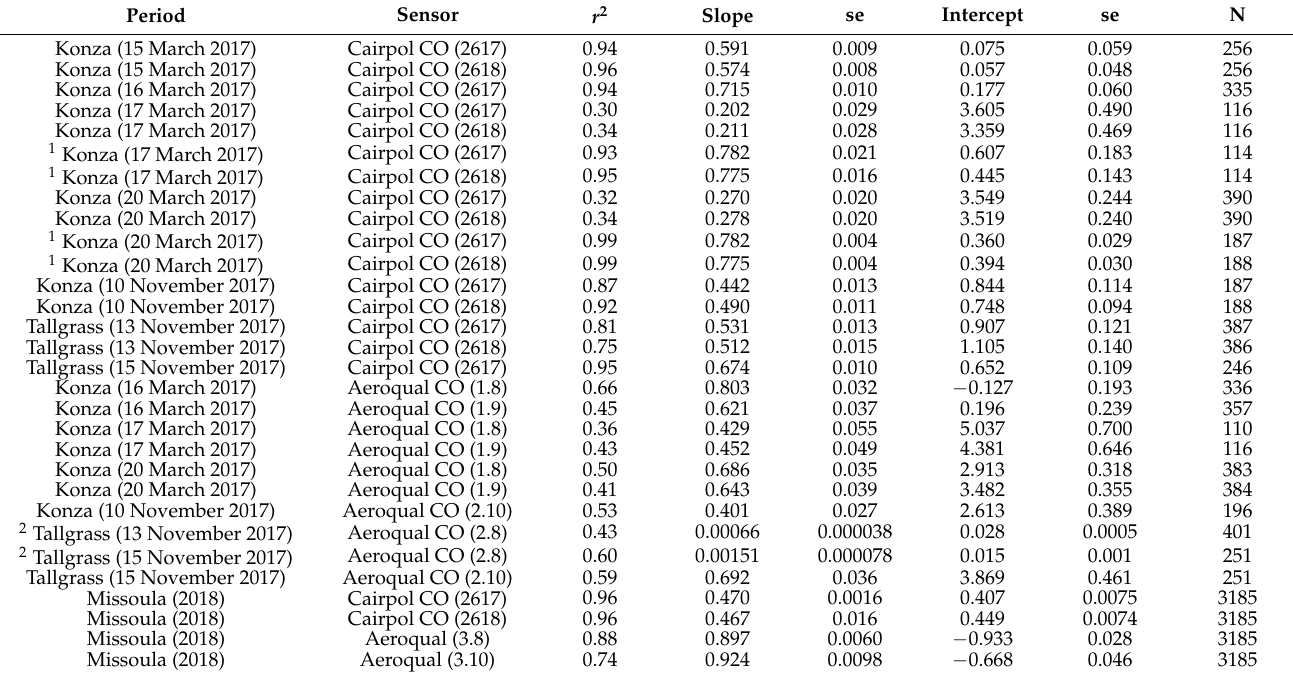
Table A1. Regression statistics for CO sensors versus reference instruments.